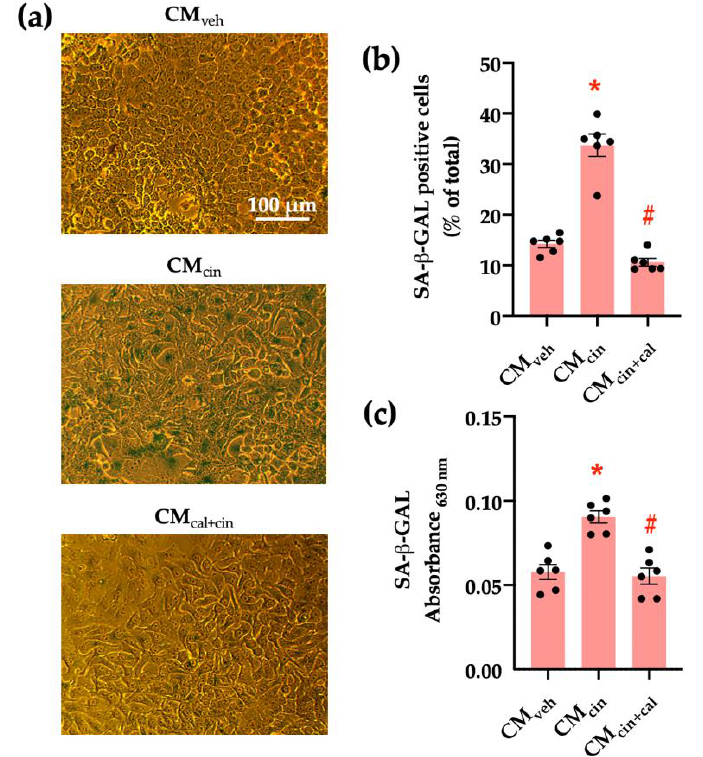
Figure 1. CaSR activation in SW872 pre-adipocytes induces the secretion of factors that induce cell senescence in HepG2 hepatocytes: ( a ) Representative images of SA- β -GAL staining of HepG2 cells exposed to the CM veh , CM cin , and CM cin+cal (scale bar = 100 µ m); ( b ) Quantification of SA- β -GAL positive cells normalized by total cells in the field; and ( c ) SA- β -GAL absorbance recorded at 630 nm. Each dot represents an individual experiment ( n = 6). * p < 0.05 versus the control, # p < 0.05 versus CM cin , Friedman ’ s test, and Dunn ’ s post-hoc test.